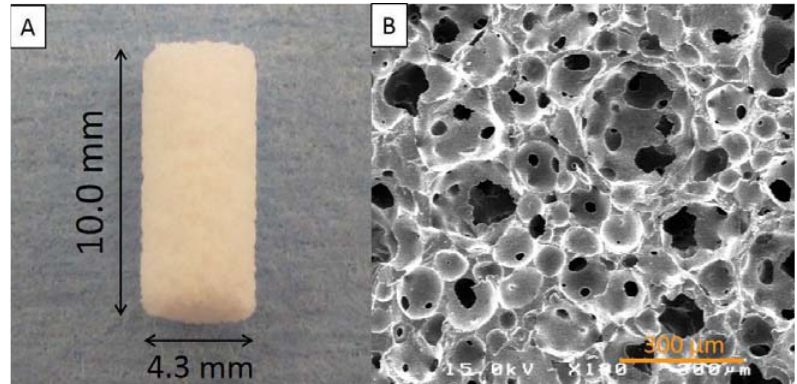
Figure 1- IP-CHA structure. (A) Photograph of prepared block-type IP-CHA cylinder; (B) A scanning electron microscope image of the IP-CHA surface. IP-CHA has a systematic arrangement of uniform pores, all of which are connected by a network of smaller interconnected